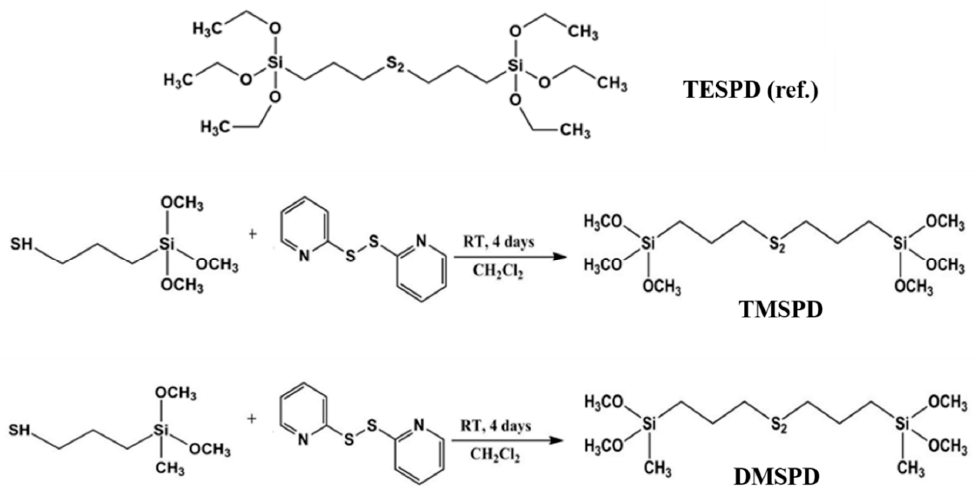
Figure 2. The chemical structure of the prepared SCAs.